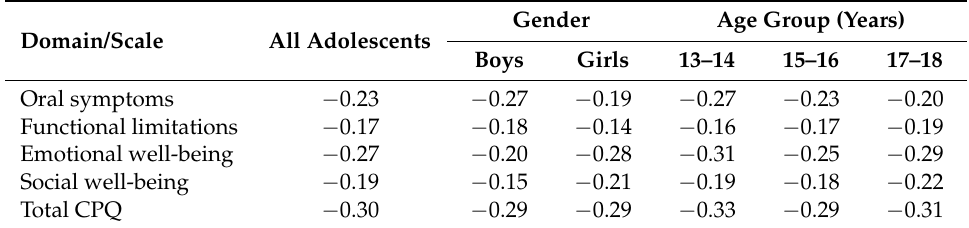
Table 3. Spearman correlation coefficients a between the ratings of global life satisfaction and the CPQ domain scores, by gender and age groups.